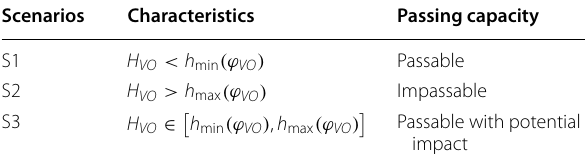
Table 4 Vertical obstacle surmounting scenarios Scenarios